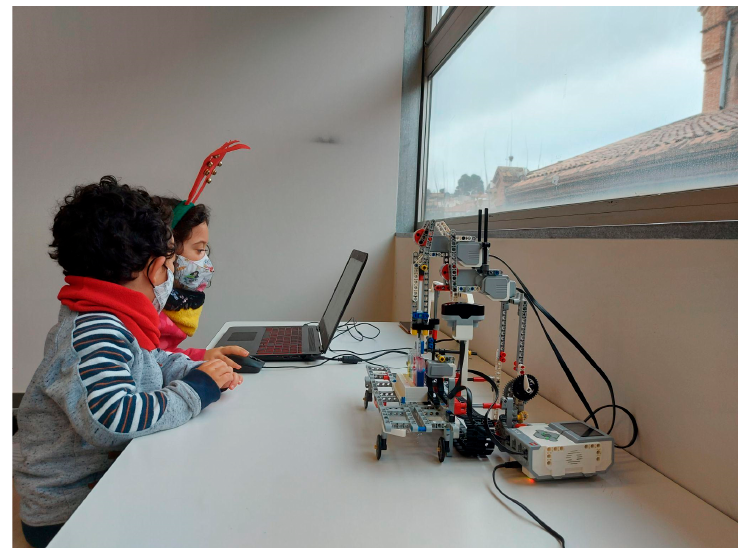
Figure 14. Testing Lab Qui-Bot in early ages.